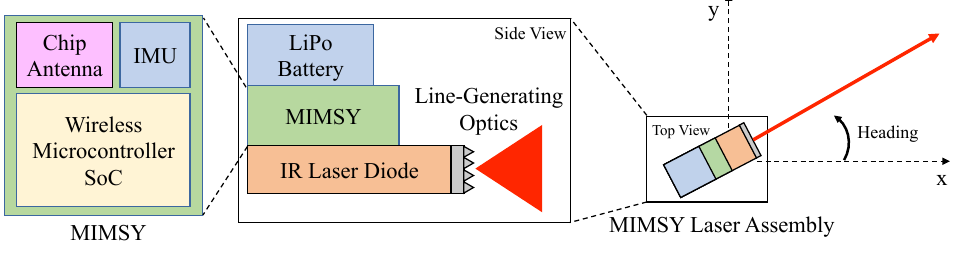
Figure 4. System Block Diagram.